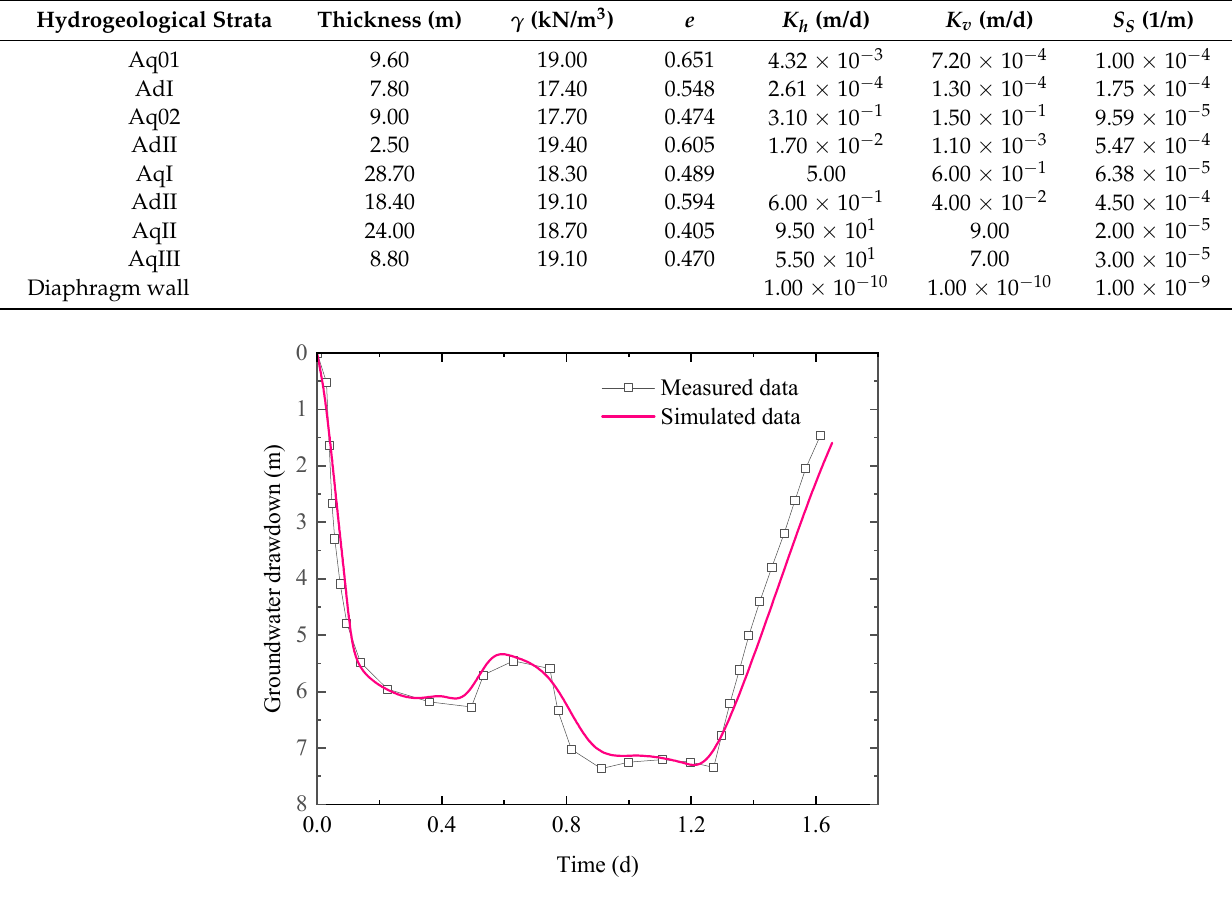
Figure 7. Comparison of measured and simulated groundwater drawdown of the observation well OB1.